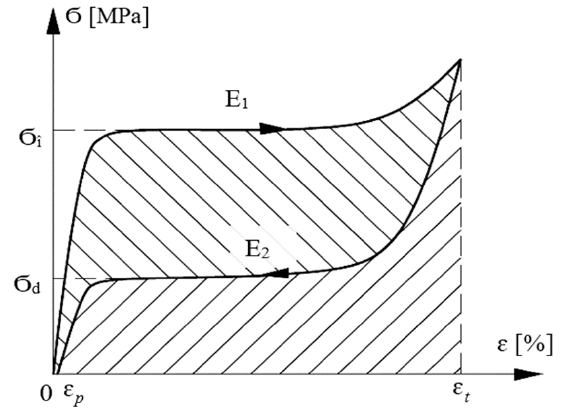
Figure 1. Schematic stress-superelastic deformation curve.